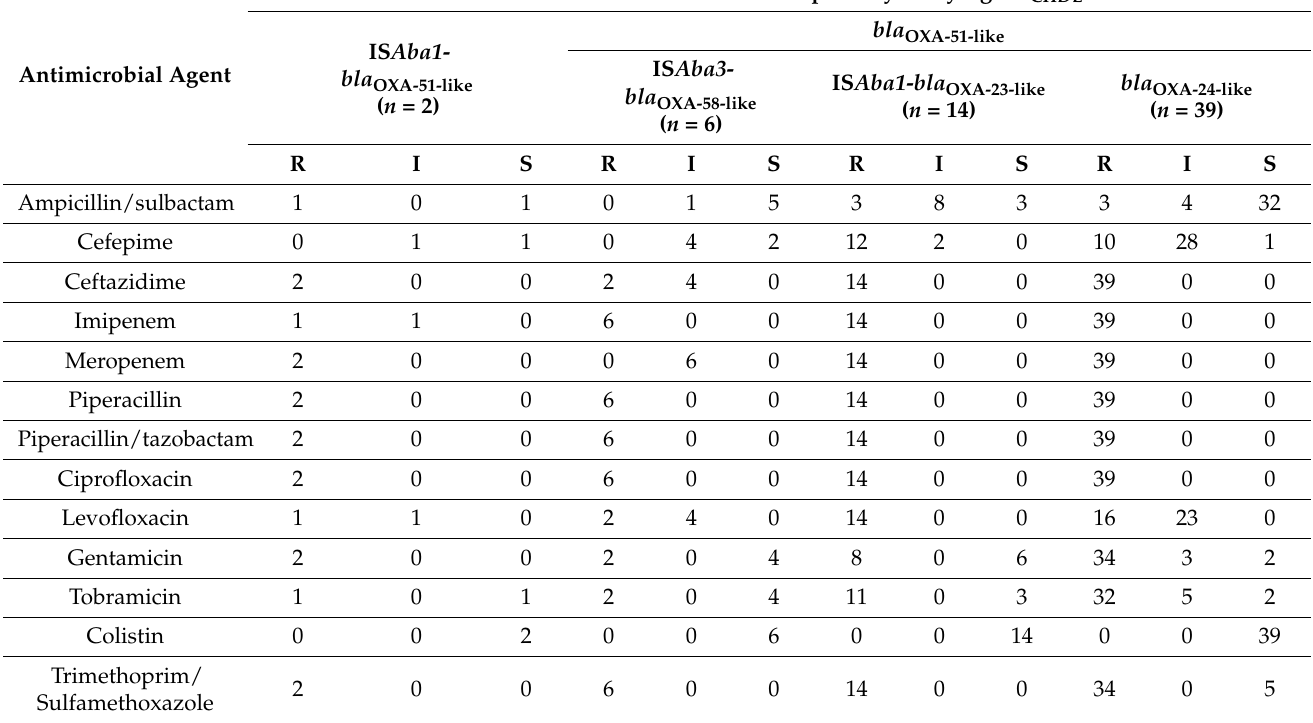
Table 1. The susceptibility profiles of A. baumannii isolates ( n = 61) carrying bla CHDL genes. No. of Isolates with the Indicated Susceptibility Carrying bla CHDL